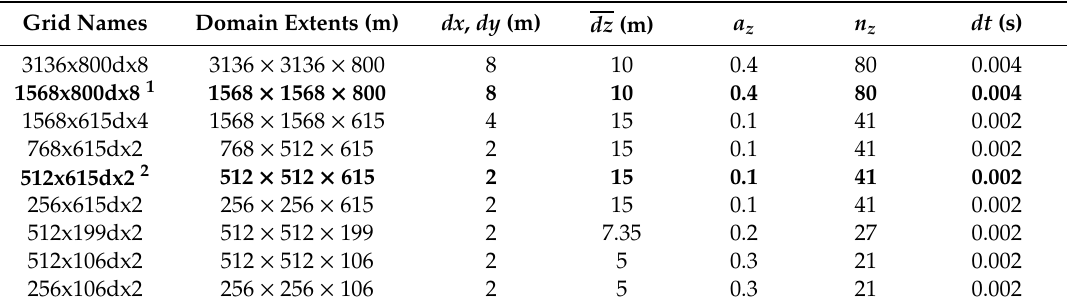
Table 3. Description of grid configurations and timesteps used in the present study. dz is the mean cell height (m), a z the vertical stretching factor (roughly equals to dz The vertical stretching is given by dz ( k ) = dz small timestep of the Method of Averages (Reisner 2000). The two reference simulations are in the bold.